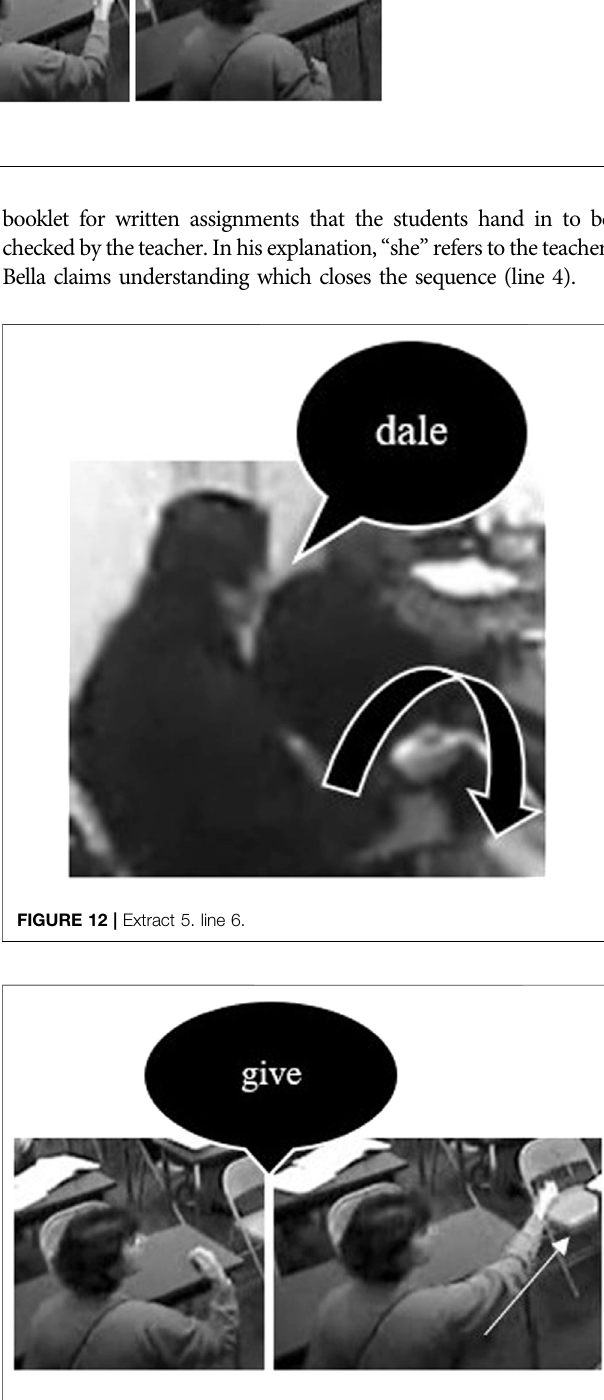
FIGURE 13 | Extract 5. line